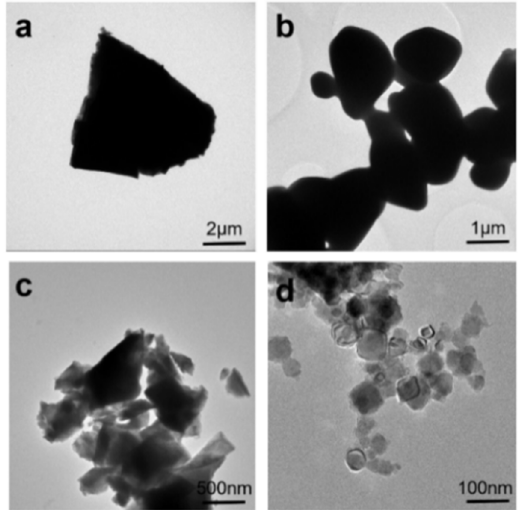
Figure 1. Powder morphologies determined by TEM of ( a ) TiH 2 powder, ( b ) Mo powder, ( c ) Zr powder, and ( d ) TiC powder.